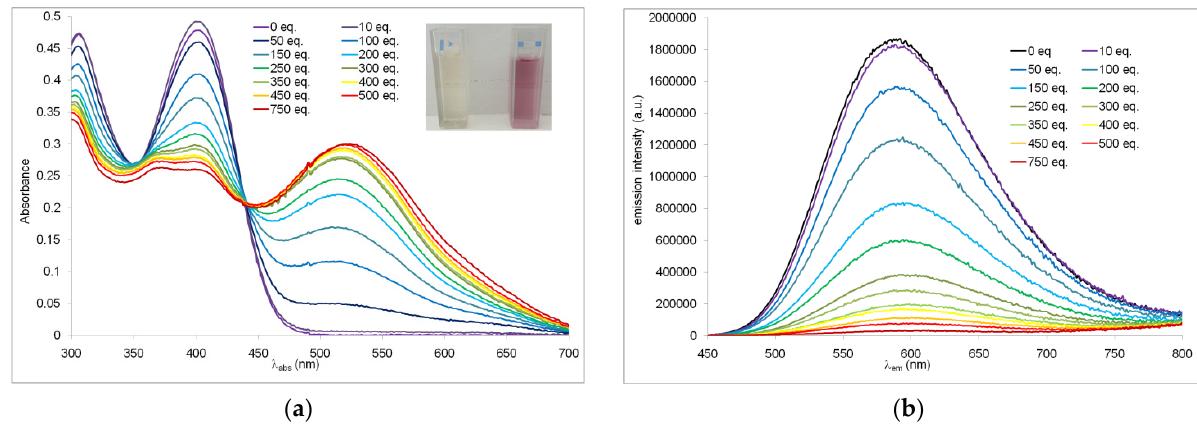
Figure 5. ( a ) Change in the absorption spectra of a DCM solution of 1 ( c = 9.4 × 10 − 6 M) upon addition of TFA (10–750 equiv) Inset: color change in a DCM solution of 1 upon addition of 750 equiv of TFA. ( b ) Change in the emission spectra of a DCM solution of 1 ( c = 9.4 × 10 − 6 M) upon addition of TFA (10–750 equiv), λ exc = 403 nm.